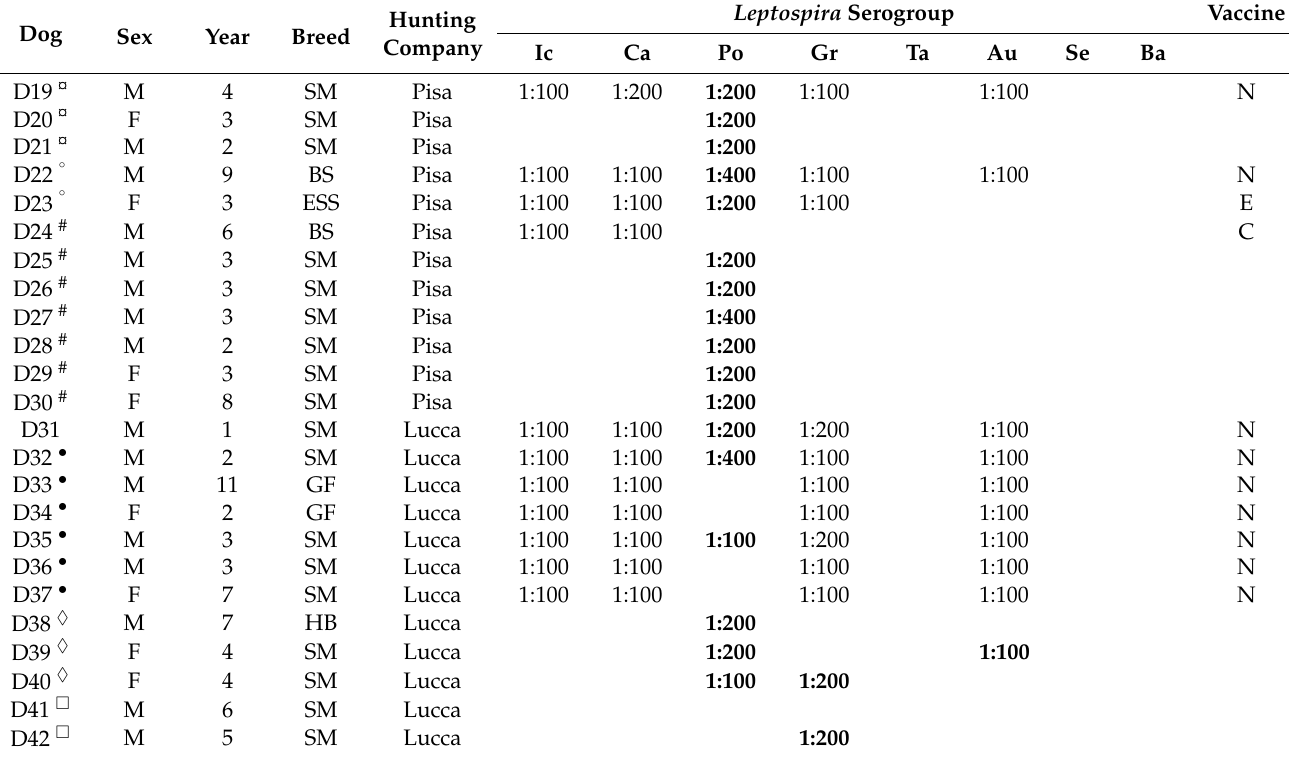
Dog IDs with same symbols from same owners. SM, Segugio Maremmano; ES, English Setter; ESS, English Springer Spaniel; BS, Brittany Spaniel; GF, Griffon Bleu de Gascogne; HB, half-breed; Ic, Icterohaemorrhagiae; Ca, Canicola; Po, Pomona; Gr, Grippotyphosa; Ta, Tarassovi; Au, Australis; Se, Sejroe; Ba, Ballum; E, Eurican L-multi ® , covering for serovars Canicola, Icterohaemorrhagiae, and Grippotyphosa; N, Nobivac L-4 ® , covering for serovars Canicola, Icterohaemorrhagiae, Bratislava, and Grippotyphosa; C, Canigen DHPPi/L ® , covering for serovars Canicola and